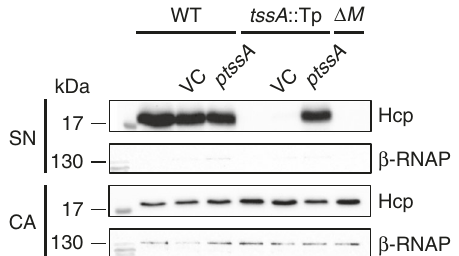
Fig. 3 Effect of TssA1 B inactivation on T6SS secretion activity. Cell associated protein (CA) and spent supernatants (SN) from cultures of B. cenocepacia H111 (WT) and the isogenic tssA1 B mutant ( tssA ::Tp), each with or without pBBR1MCS (VC) or pBBR1MCS-tssA1 B ( ptssA ), were fractionated by SDS-PAGE, blotted onto PVDF membrane and probed with a Hcp pAb or a mAb speci fi c for the RNAP β subunit (lysis control). Detection of bound antibodies was with HRP-conjugated secondary antibodies. The tssM mutant ( Δ M ) was included as a control as TssM has been shown to be an essential component of the B. cenocepacia T6SS 31 . Uncropped images of the blots are shown in Supplementary